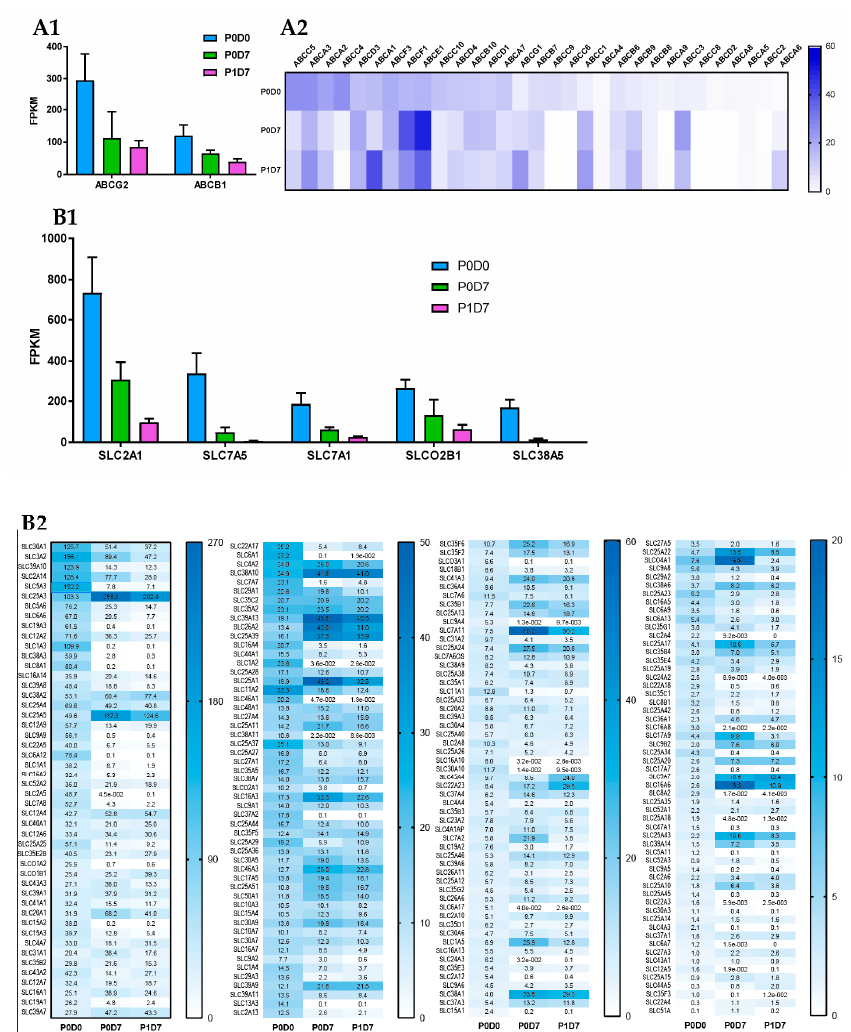
Figure 4. Changes in mRNA levels of ABC and SLC transporters across P0D0, P0D7 and BEC fractions. ( A ) Comparison of the expression levels (FPKM) between the different ABC transporters present in the brain microvascular P0D0, P0D7 and P1D7 fractions. ( A1 ) ABCB1 and ABCG2 are by far the most expressed ABC transporters across the 3 cell population fractions. Results represent average FPKM and are expressed and mean ± SD ( n = 6–8). ( B ) Comparison of the expression levels (FPKM) between the different SLC transporters present in the brain microvascular P0D0, P0D7 and P1D7 fractions. ( B1 ) SLC2A1, SLC7A5, SLC7A1, SLCO2B1, SLC3A2 and SLC38A5 are the most expressed SLC transporters at P0D0 but are downregulated in vitro. Results represent average FPKM and are expressed and mean ± SD ( n = 6–8).